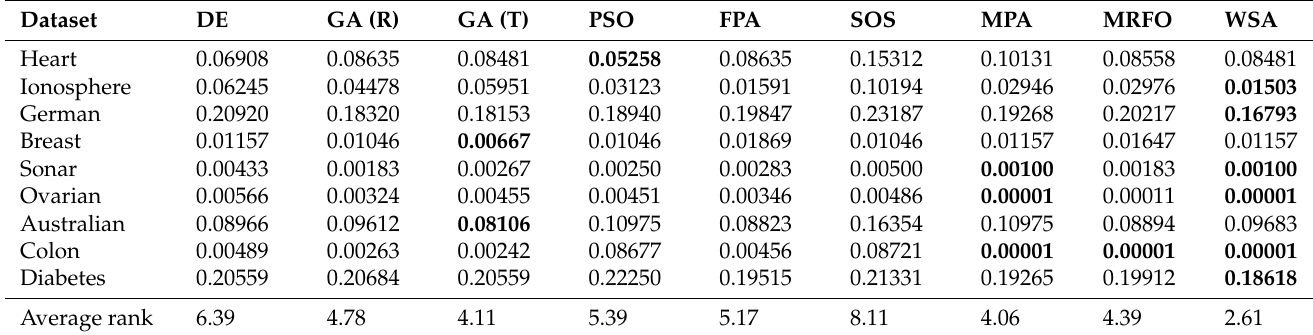
Table 3. Best fitness function value achieved by each algorithm for each dataset.